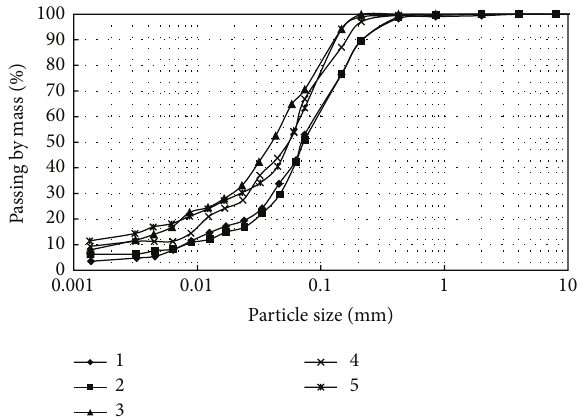
Figure 1: Grain size distribution of materials